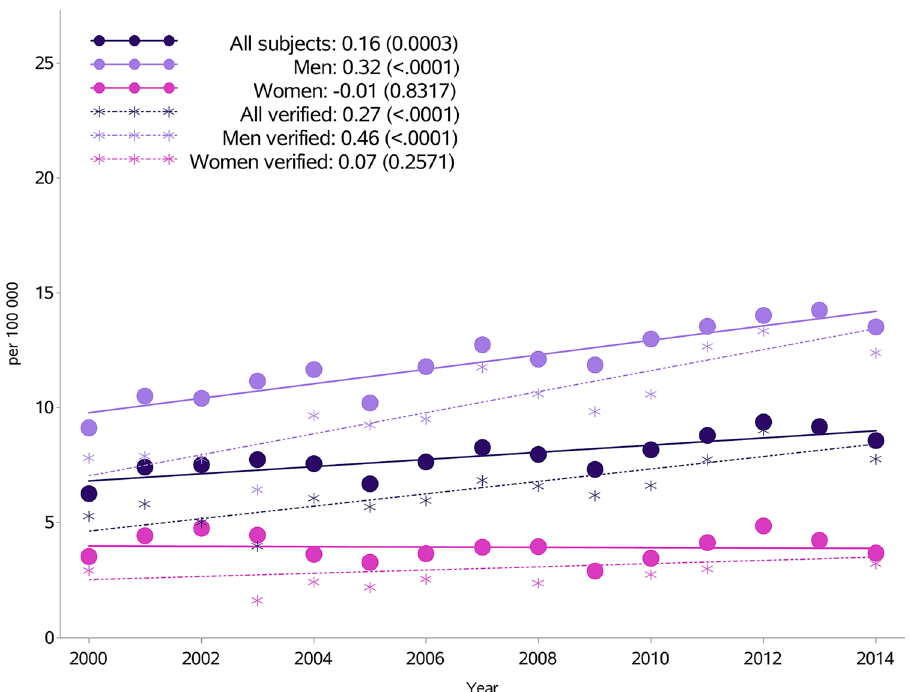
Figure 1. Incidence of myocarditis per 100,000 inhabitants in Sweden from 2000 to 2014 by sex, with or without validation in a subpopulation with a diagnosis of myocarditis validated from 2000 to